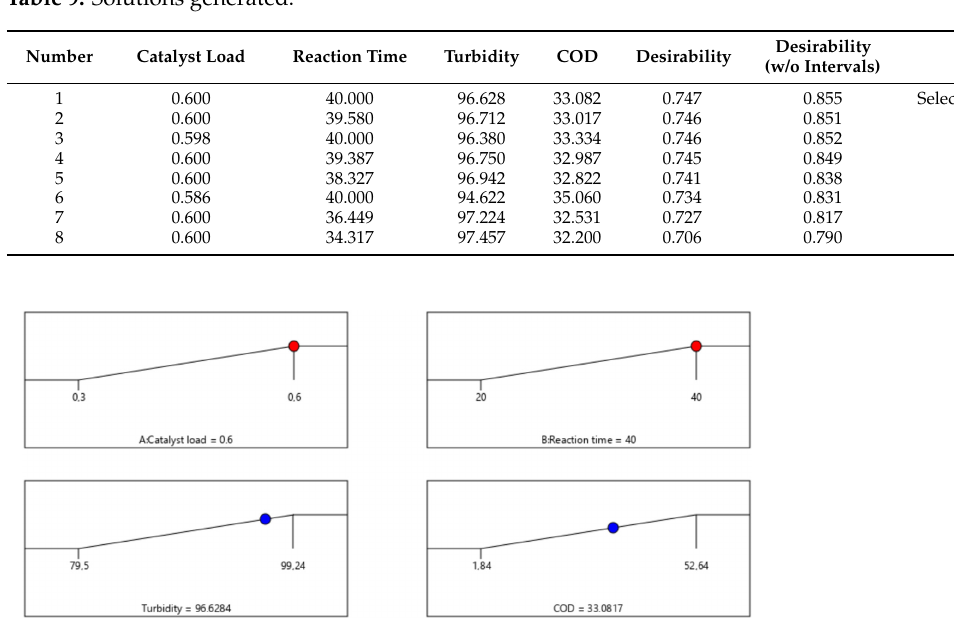
Table 10. Modified RSM-CCD optimum conditions experimental